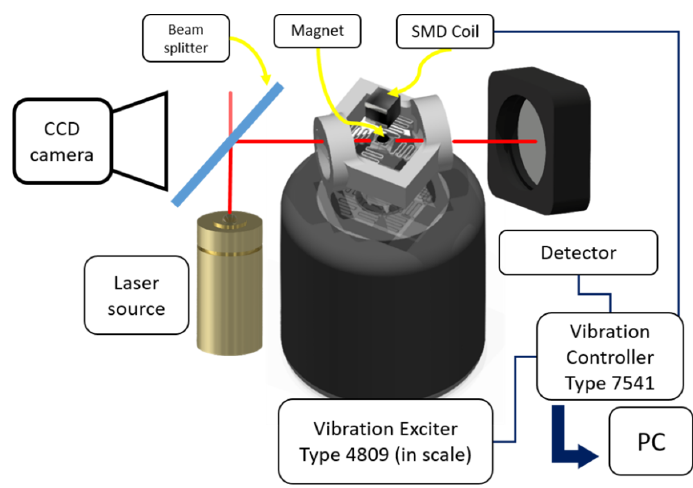
Figure 2. Scheme of the measurement set-up (optical and electrical) applied in the vibrational energy harvester’s characterization.